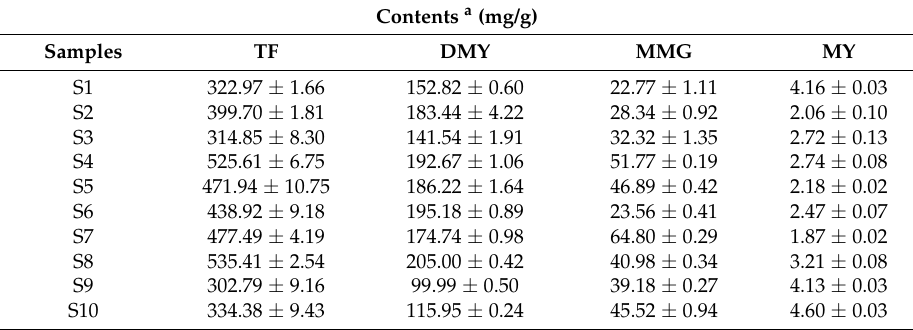
Contents of the total flavonoids, dihydromyricetin, myricitrin and myricetin in Ampelopsis grossedentata leaves from different